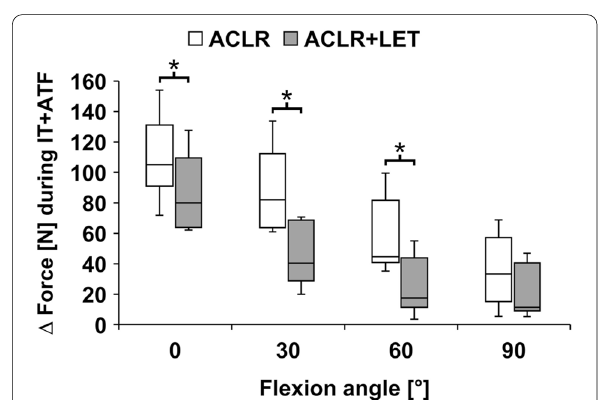
Fig. 5 Graft forces in the anterior cruciate ligament reconstruction (ACLR) during the application of combined internal tibial torque and anterior tibial translation force (IT ATF) for the isolated ACLR and the + ACLR with addition of a lateral extra-articular tenodesis (ACLR LET). + The forces indicated in the graph are relative to the unloaded state (Δ force). Significant differences between the two procedures are marked with an asterisk (*)